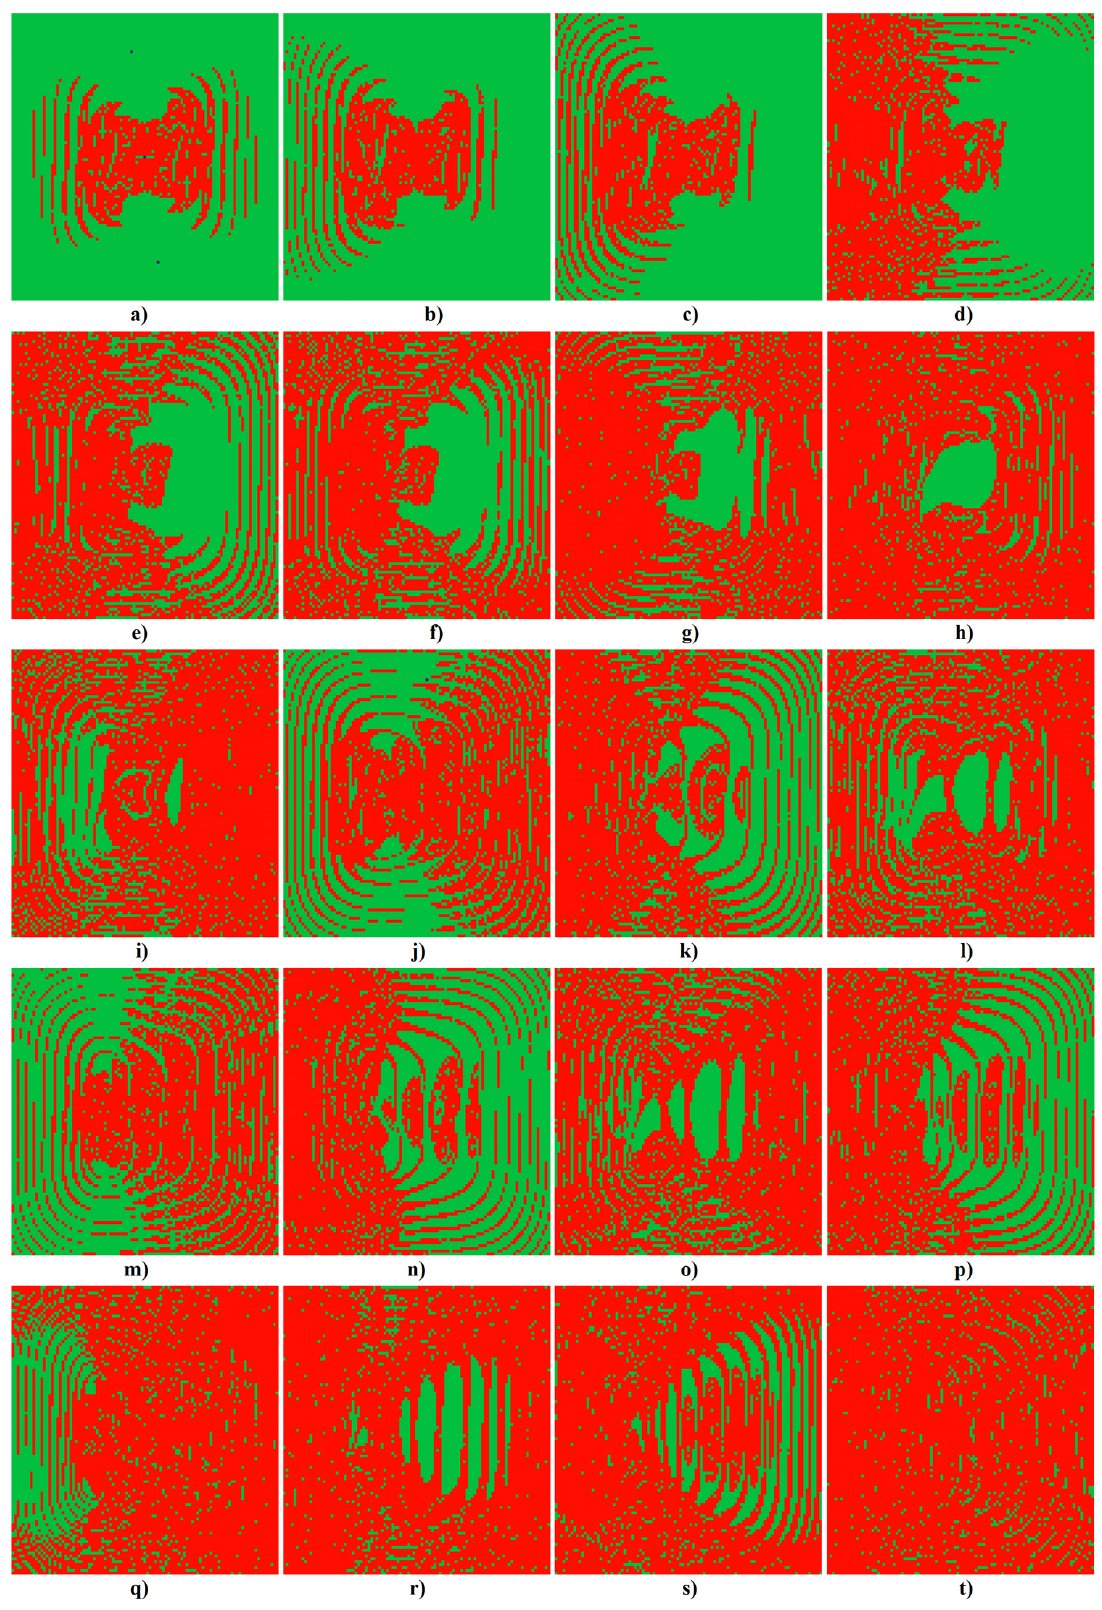
Figure 4. Basins of attraction calculated as horizontal slices of a state space: ( a ) i L = 0, ( b ) i L = 0.1, ( c ) i L = 0.2, ( d ) i L = 0.5, ( e ) i L = 0.7, ( f ) i L = 0.8, ( g ) i L = 1, ( h ) i L = 1.5, ( i ) i L = 2.0, ( j ) i L = 2.5, ( k ) i L = 3.0, ( l ) i L = 3.5, ( m ) i L = 4, ( n ) i L = 4.5, ( o ) i L = 5, ( p ) i L = 6, ( q ) i L = 8, ( r ) i L = 10, ( s ) i L = 11, and ( t ) i L = 12.